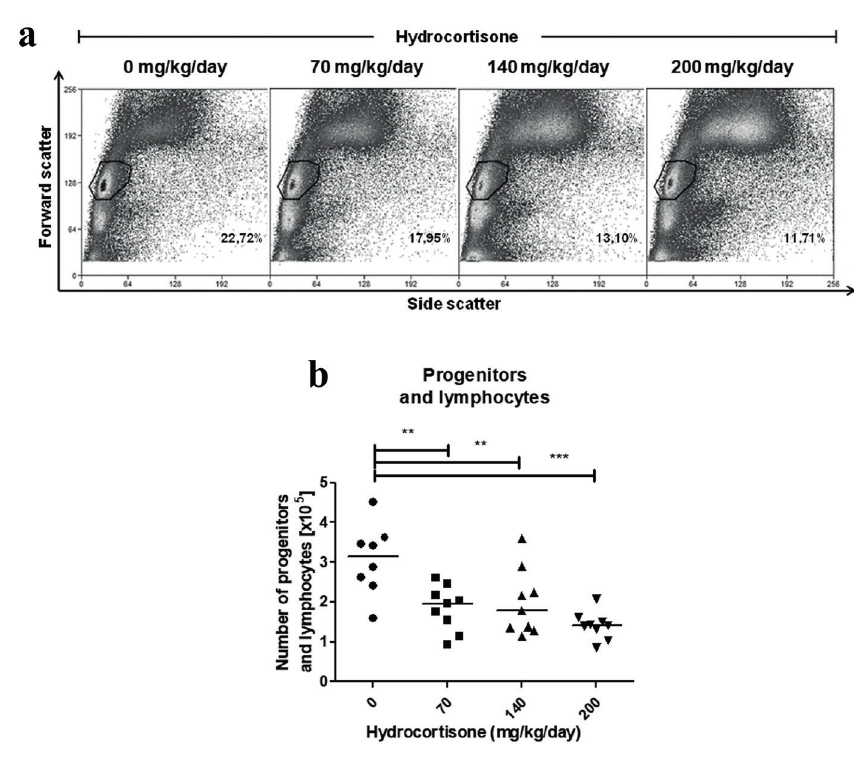
Figure 1 - Effect of in vivo treatment with hydrocortisone on bone marrow cells. Mice were injected with diluent or hydrocortisone (70, 140 or 200 mg/kg/day) for 3 consecutive days. In the next day, bone marrow cells were counted and analyzed by flow cytometry. ( a ) Percentage and ( b ) total number of progenitors and lymphocytes. Line represents the median, (**) represents values of p<0.01 and (***) p<0.001, according to the statistical test. Results are representative of 3 independent experiments with 3 mice/group